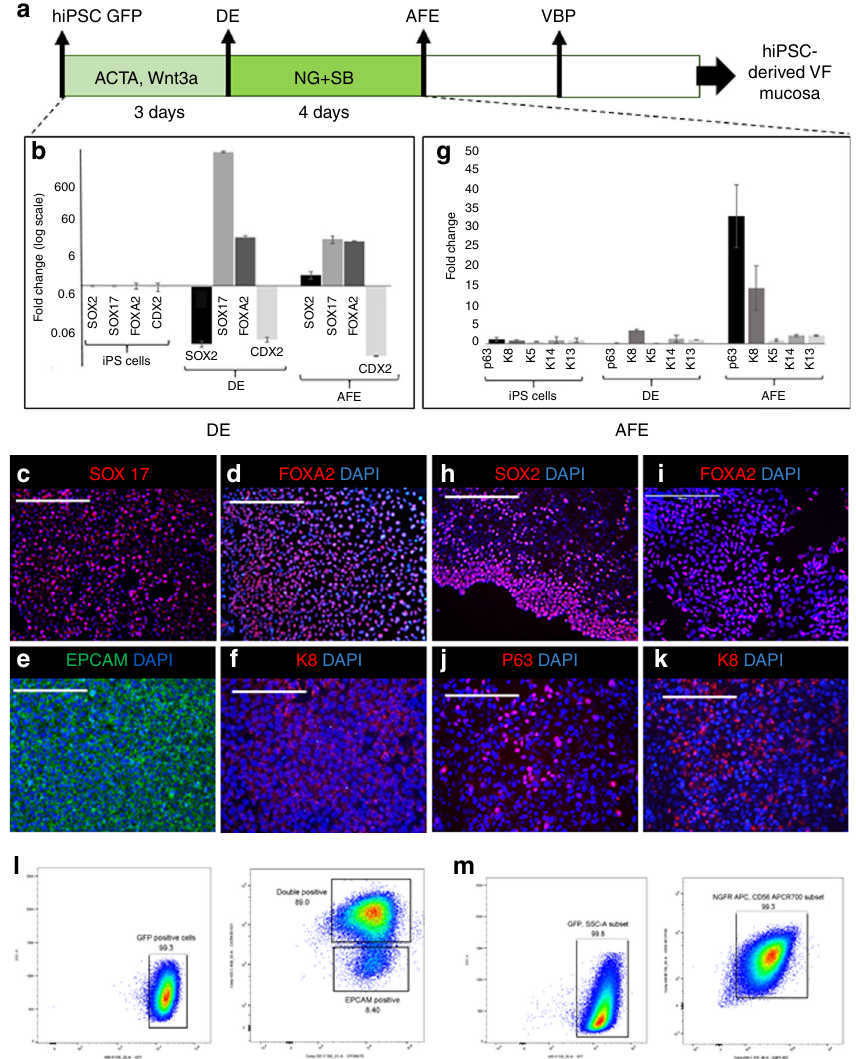
Fig. 2 Generation of anterior foregut cell cultures from DE monolayers. a Differentiation of hiPSC into the DE and AFE. b – k Expression levels of the markers of the DE and AFE during differentiation characterized with quantitative polymerase chain reaction ( b , g ) and immuno fl uorescent staining for SOX17 ( c ), FOXA2 ( d , i ), EPCAM ( e ), cytokeratin K8 ( f , k ), SOX2 ( h ), and p63 ( j ), scale bar = 200 μ m. Controls in b , g are hiPSC. In b , value of 0 = 1 for hiPSC control, and in g 0 = 0 expression for controls. We used one-way ANOVA to assess statistical signi fi cance between gene expression levels. Except for cytokeratin K13 with p- value = 0.06, p- values for other tested genes were below the threshold p- value < 0.05 indicating that expression levels of these genes signi fi cantly differed during differentiation. Error bars represent ± standard error of the mean, n = 3 per group. l , m Gating strategy for con fi rmation of DE and AFE cell populations by fl ow cytometry. Cell populations were sorted based on GFP expression and CXCR4 and EPCAM for DE ( l ) and CD56 and NGFR + for AFE ( m ). ACTA activin A, AFE anterior foregut endoderm, DE de fi nitive endoderm, hiPSC human induced pluripotent stem cells, VBP vocal fold basal progenitors. Source data provided as a Source Data fi and combination of high levels of FGF2 (250 ng/ml), FGF10 (100 ng/ml), and FGF7 (100 ng/ml) (group 4) with the medium changed every other day (Fig. 3a). At day 12, we compared the